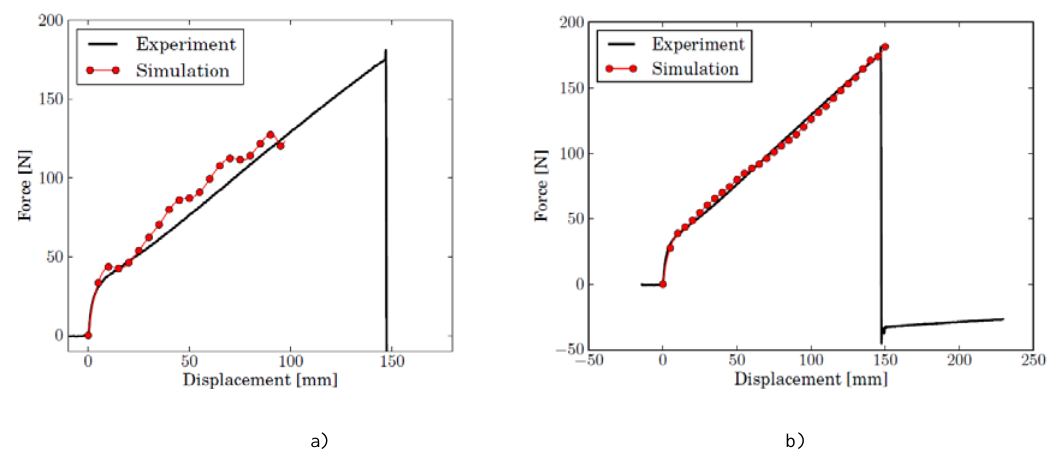
Fig. 12 Force vs. displacement for uniaxial tensile test at 0.5 m/s and 23.2 °C; a) simulation using 10th-order reduced polynomial hyperelastic law and viscoelasticity; b) simulation using 20th-order reduced polynomial hyperelastic law.